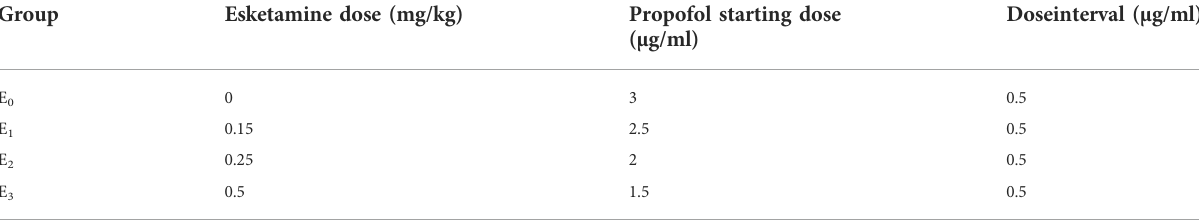
TABLE 1 Drug dosage of esketamine and propofol for each group.